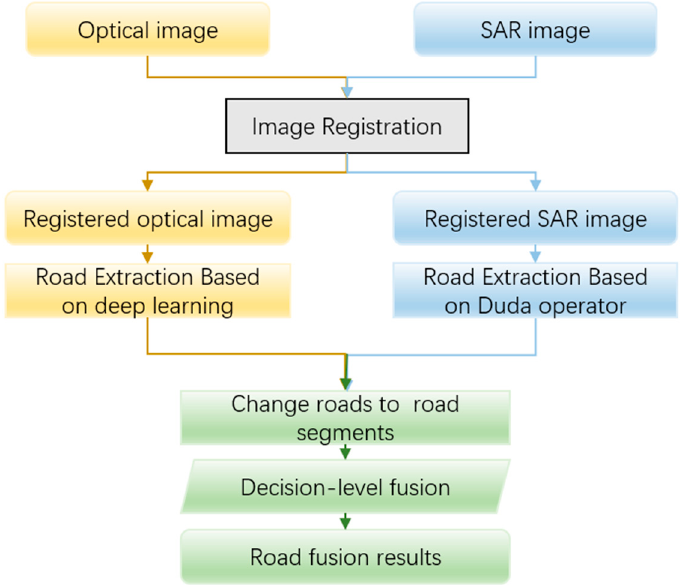
Figure 10. Low-grade road extraction algorithm for decision-level fusion of optical and SAR